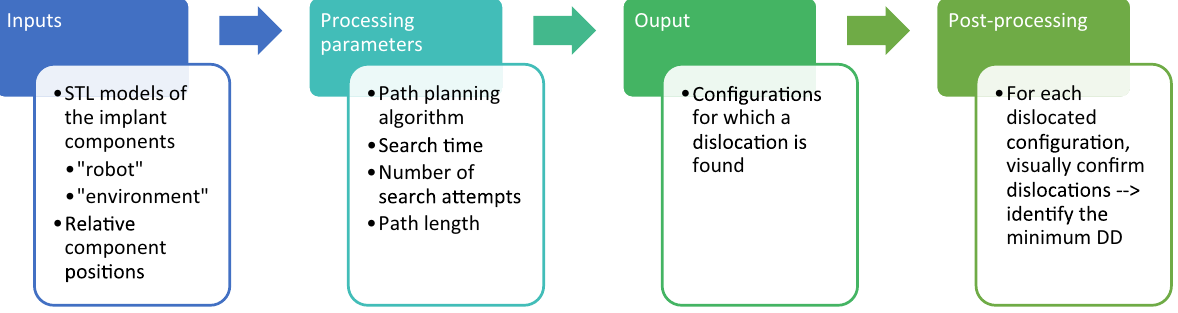
Figure 1. Flow chart to demonstrate how the dislocation analysis tool